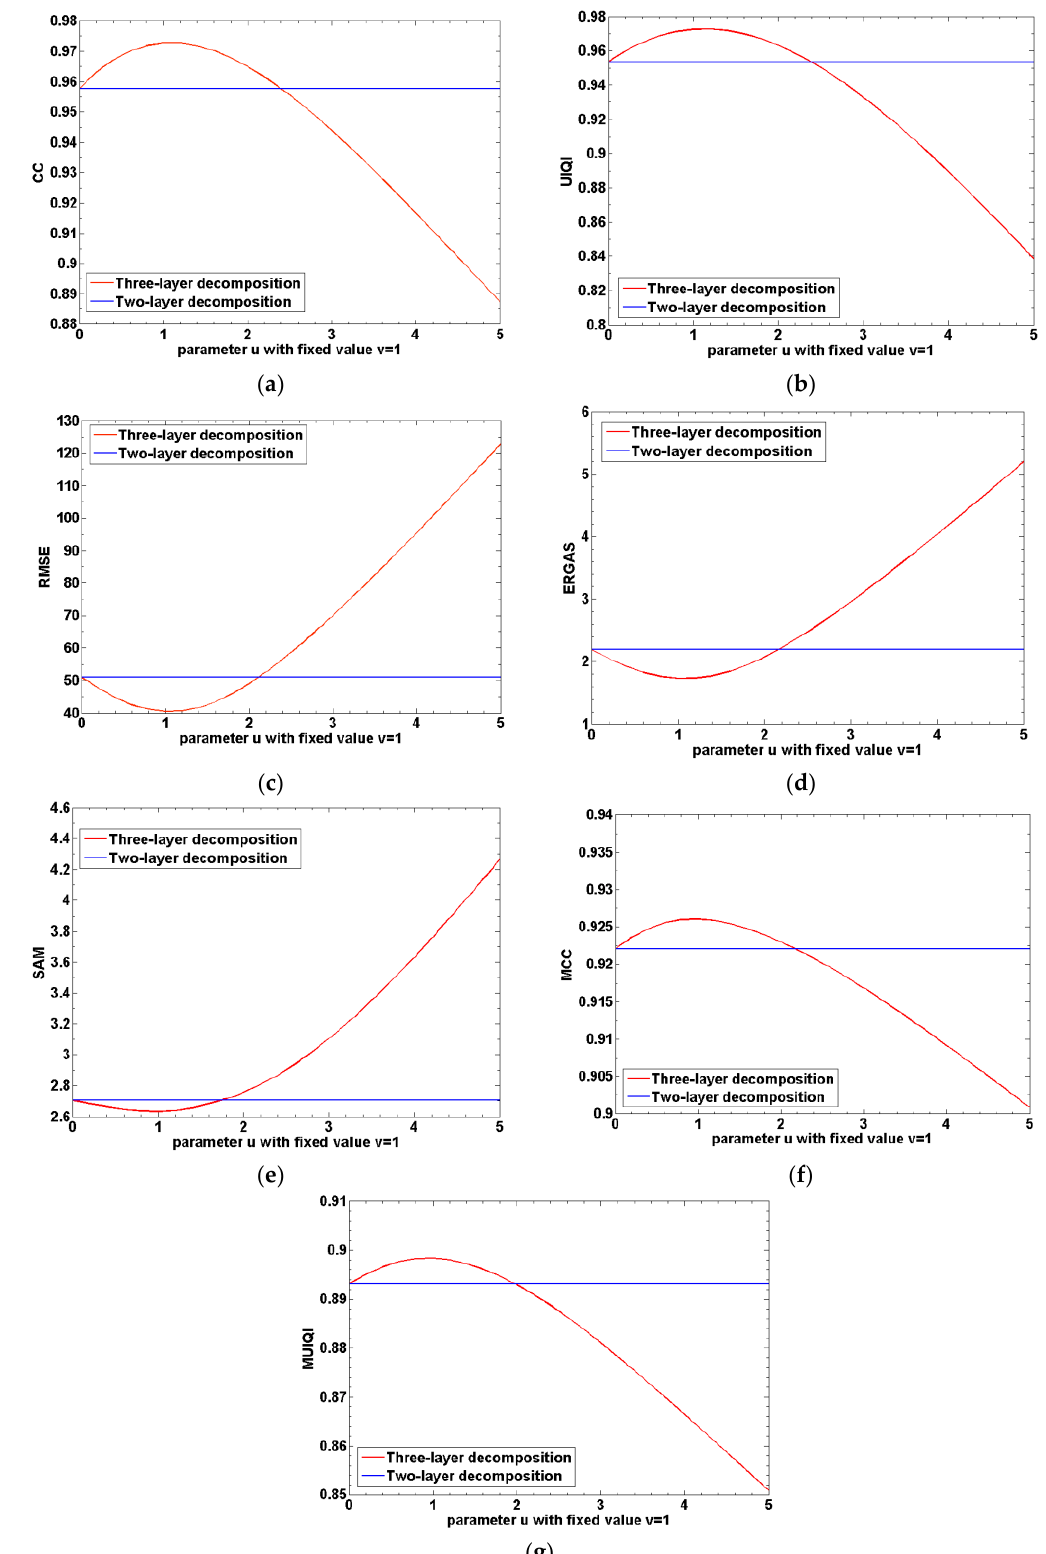
Figure 10. The statistical results for the comparison of the proposed three-layer decomposition to the two-layer decomposition. ( a ) Results of CC; ( b ) results of UIQI; ( c ) results of RMSE; ( d ) results of ERGAS; ( e ) results of SAM; ( f ) results of MCC; ( g ) results of MUIQI.